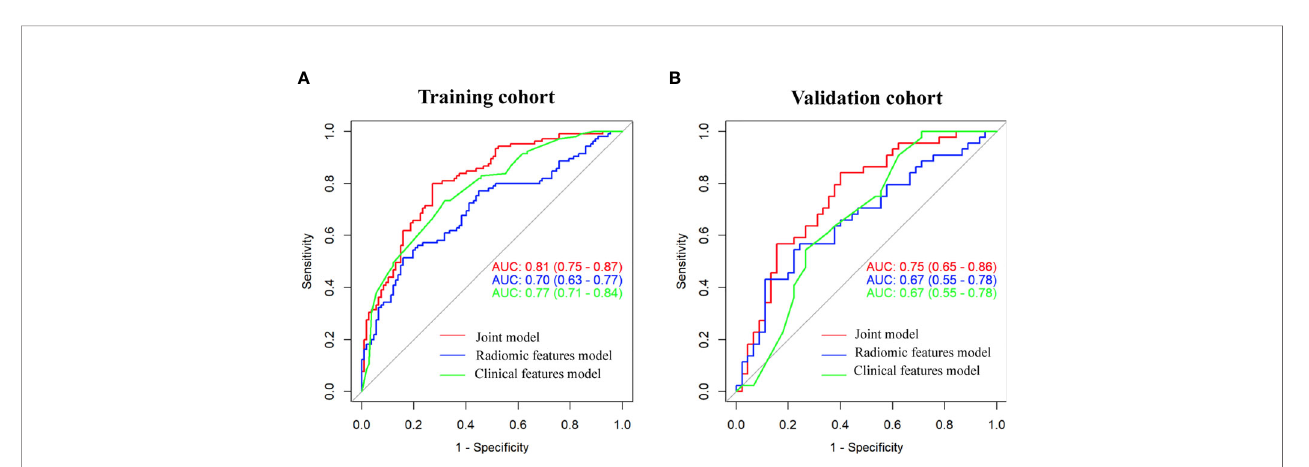
FIGURE 3 | Comparison of performance among the three developed models for the prediction of EGFR-activating mutations in NSCLC patients. ROC curves of clinical features alone, radiomic features alone and combined features in the training (A) and validation (B)